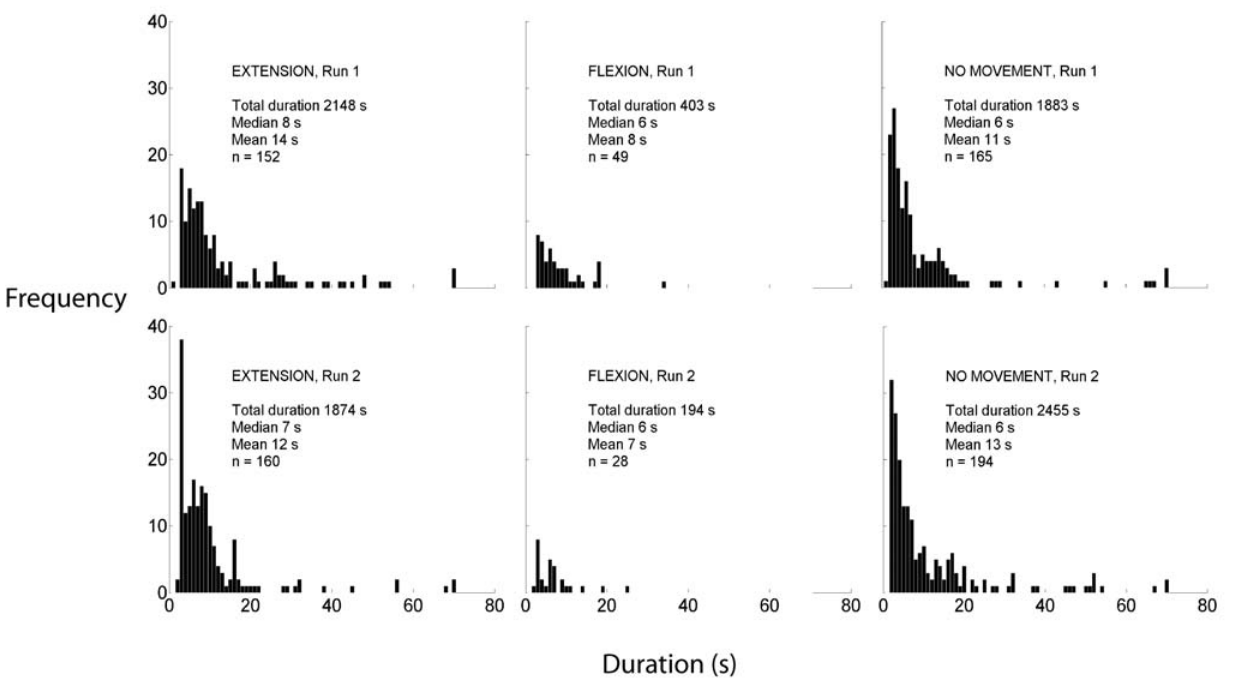
Figure 3. Histograms showing durations of individual instances of Extension, Flexion and No movement periods during adaptation. The upper limit for the x-axes has been set at 80 because there were only 9 points above that value (either Extensions or No movement occurrences).